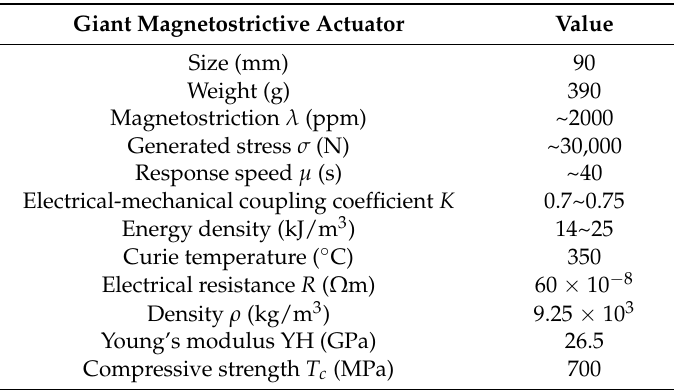
Figure 3. Installation of giant magnetostrictive actuator. Table 1. Specification of giant magnetostrictive actuator.